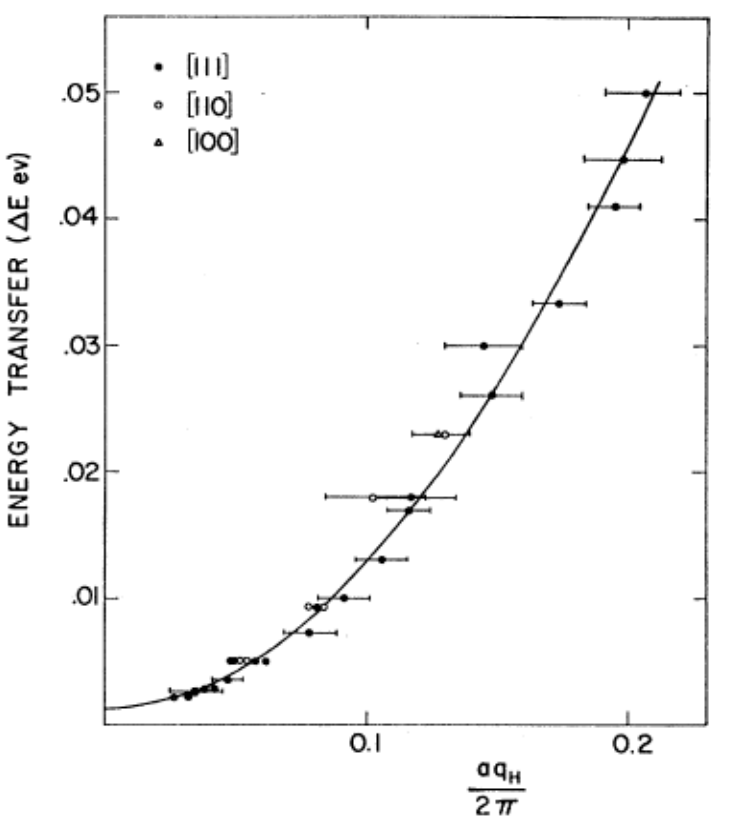
Figure 45. The energy transfer ∆ E as a function of the reduced wavevector for spin waves in a Co 0 . 92 Fe 0 . 08 alloy. The error bars are about half the full-width at half-maximum of the neutron groups. The solid line is the best fit to the functional form of a spin-wave dispersion plus a small constant anisotropy term, namely ∆ E = A + Dq 2 . This figure is taken from Figure 2 of ref. [110]. Copyright by the American Physical Society.